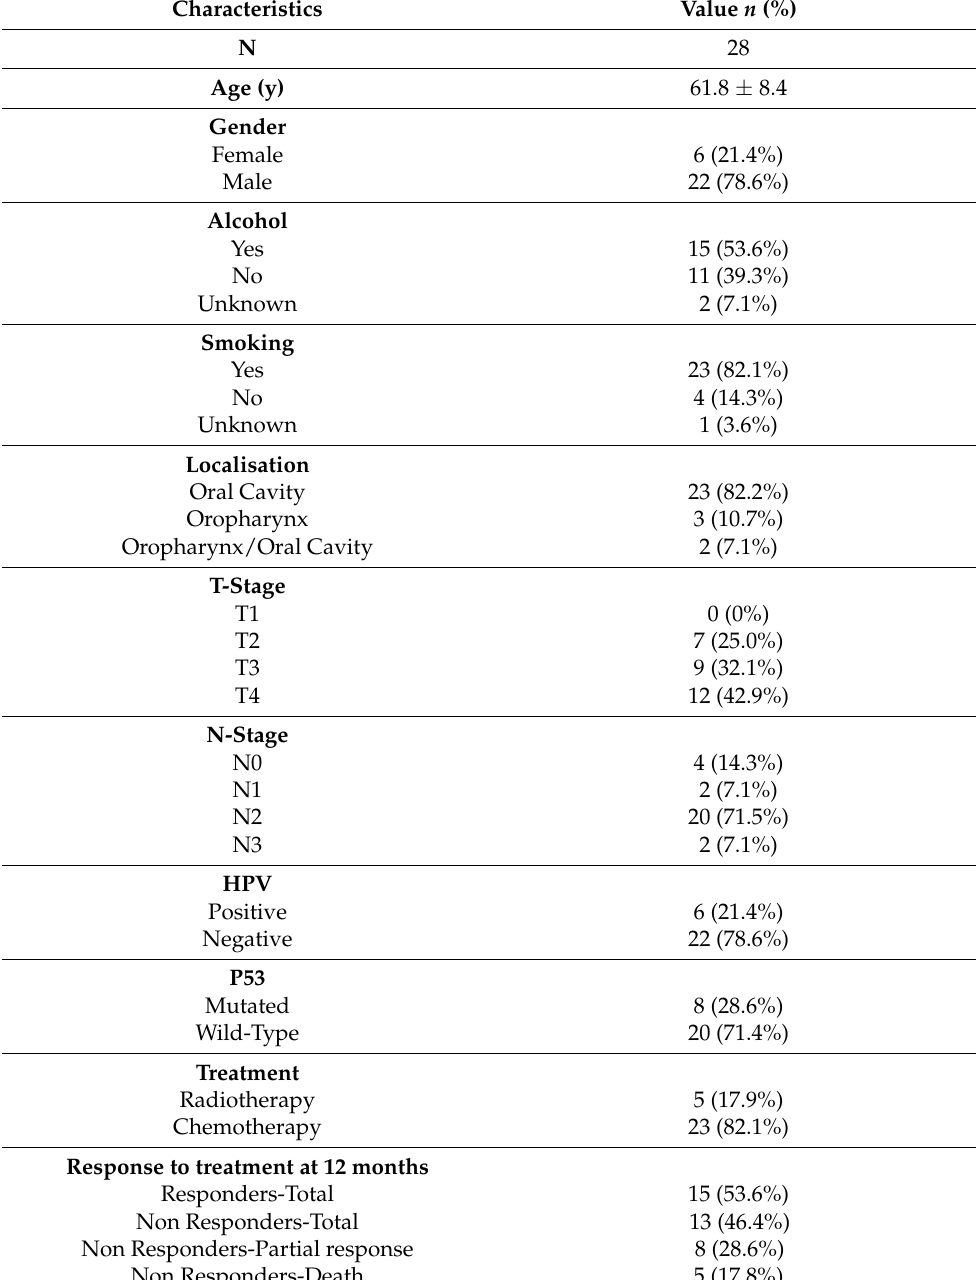
Table 1. Clinico-pathological characteristics of